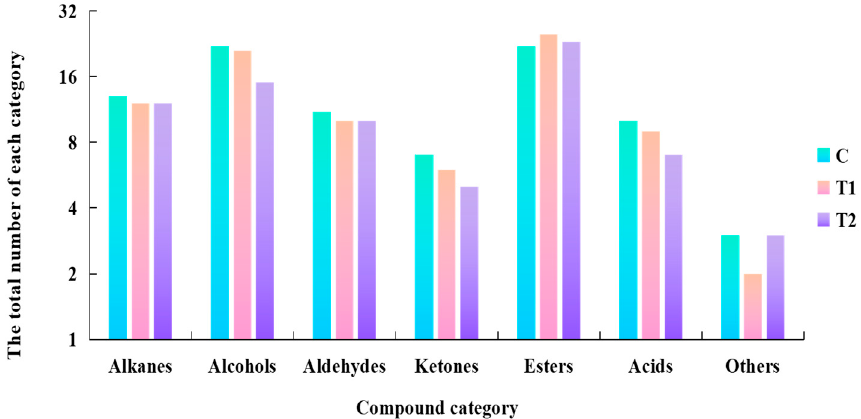
Figure 2. The total number of volatile compounds in three groups. It showed the total number of alkanes, alcohols, aldehydes, ketones, esters, acids and others in the three groups. C: Control group; T1: test group 1 (using the improved technology of Sichuan spicy flavor formula); T2: test group 2 (using the improved technology of halogen flavor formula). Table 6. The effect of the improvement on the relative content of volatile compounds (%) in